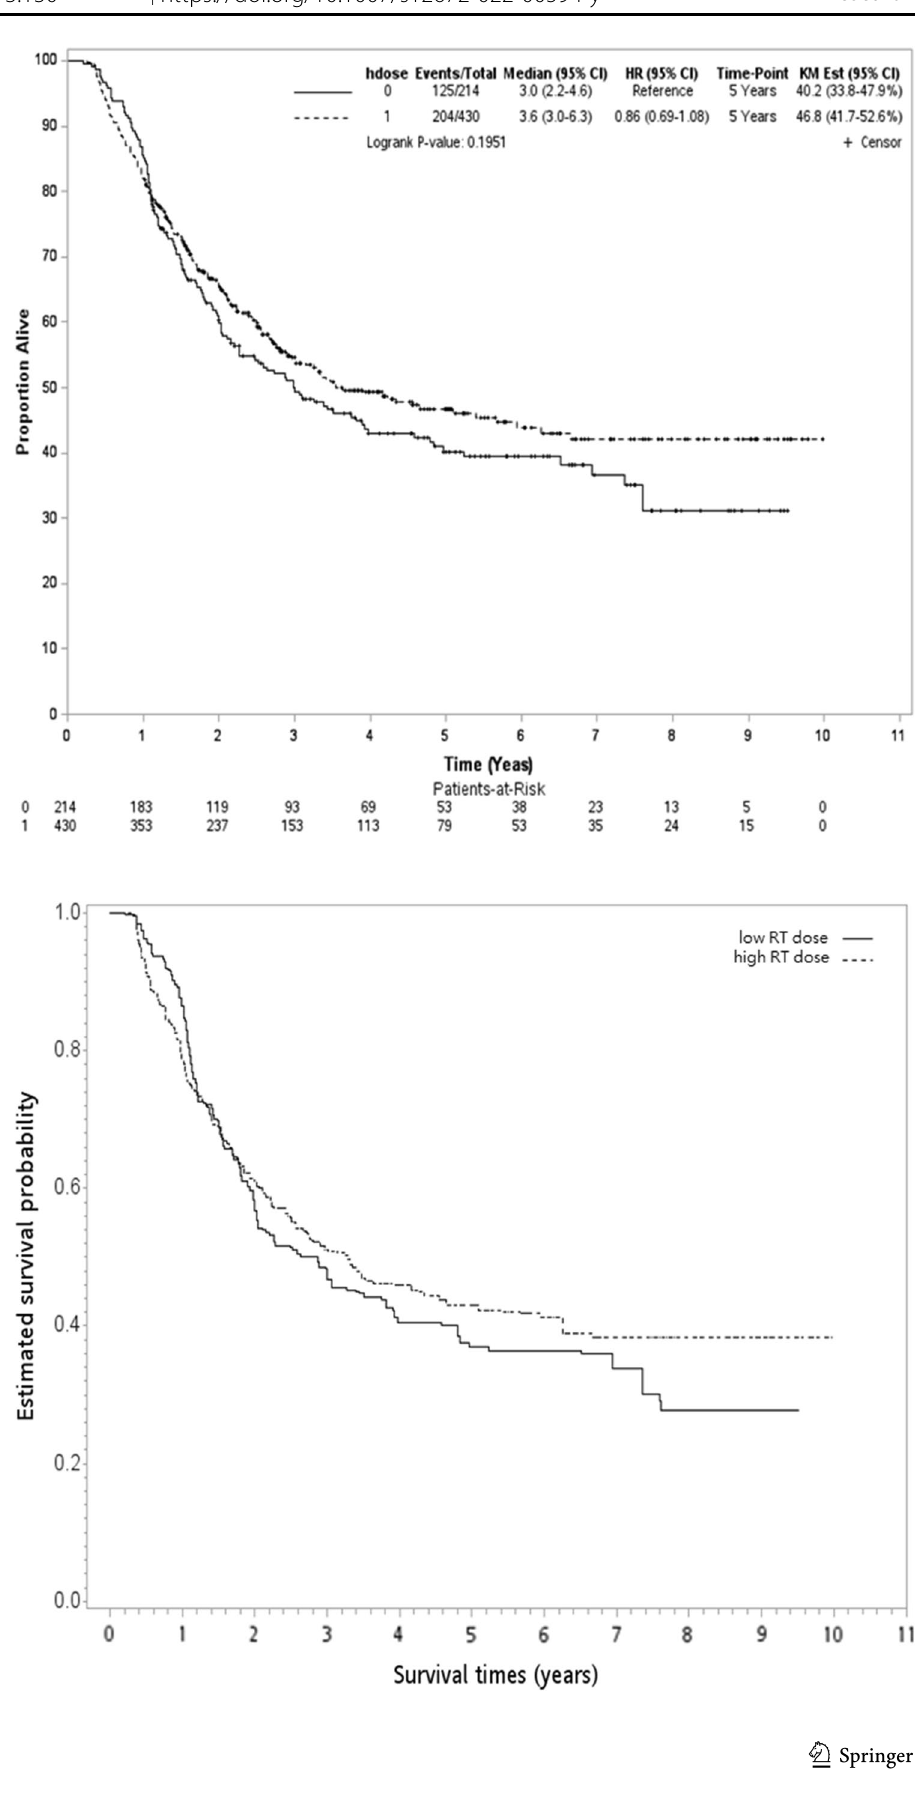
Fig. 2 Kaplan–Meier unad- justed overall survival curve (in years) in the primary analy- sis. hdose high dose